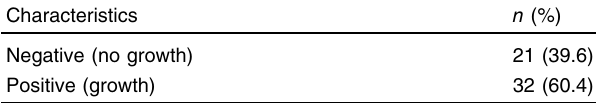
Table 3 Sputum culture results in the studied groups